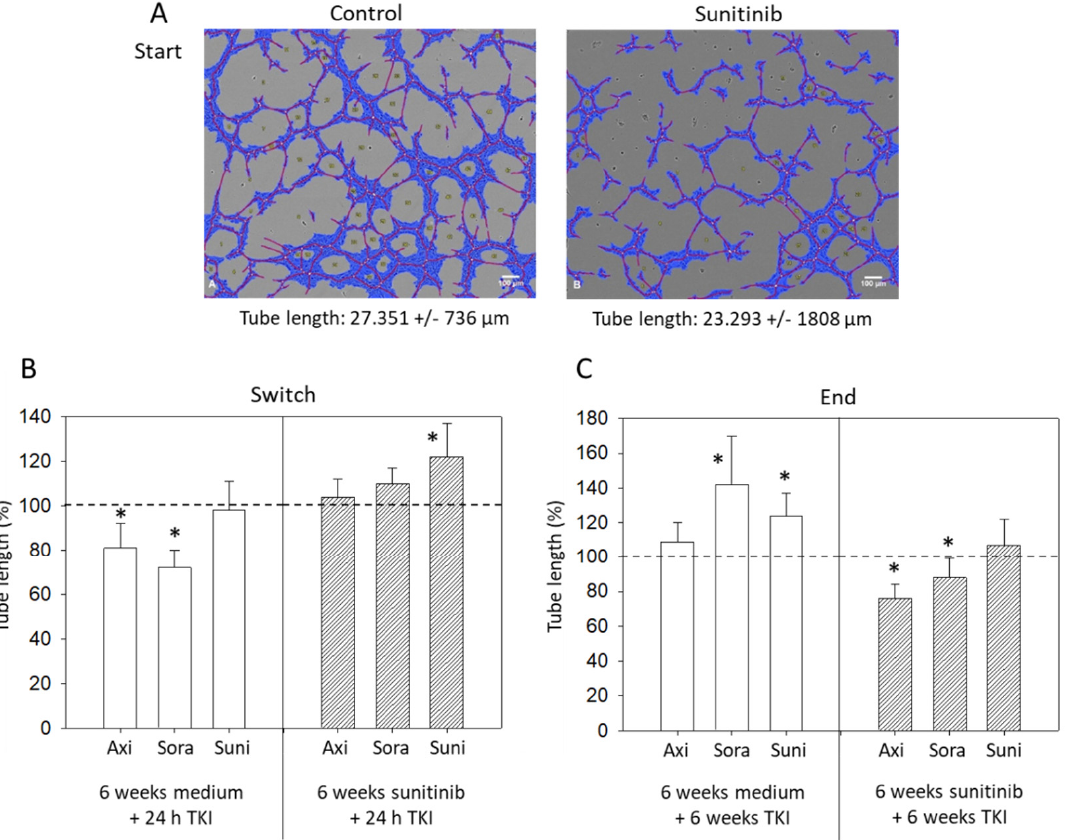
Figure 5. ( A ) Tube formation after 24 h sunitinib exposure, compared to untreated controls. One representative figure and the mean tube length of treated versus untreated HUVECs are shown (n = 3). Blue = cell covered area, red = tubes, yellow = branching points. ( B ) Evaluation of tube length after 6 weeks sunitinib (6 weeks sunitinib + 24 h TKI) or cell culture medium (6 weeks medium + 24 h TKI) followed by 24 h axitinib, sorafenib or sunitinib (Switch). Untreated controls were set to 100%. * indicates significant difference to the untreated controls. ( C ) Evaluation of tube length after 6 weeks sunitinib (6 weeks sunitinib + 6 weeks TKI) or cell culture medium (6 weeks medium + 6 weeks TKI) followed by 6 weeks axitinib, sorafenib or sunitinib (End). Untreated controls were set to 100%. * indicates significant difference to untreated controls.